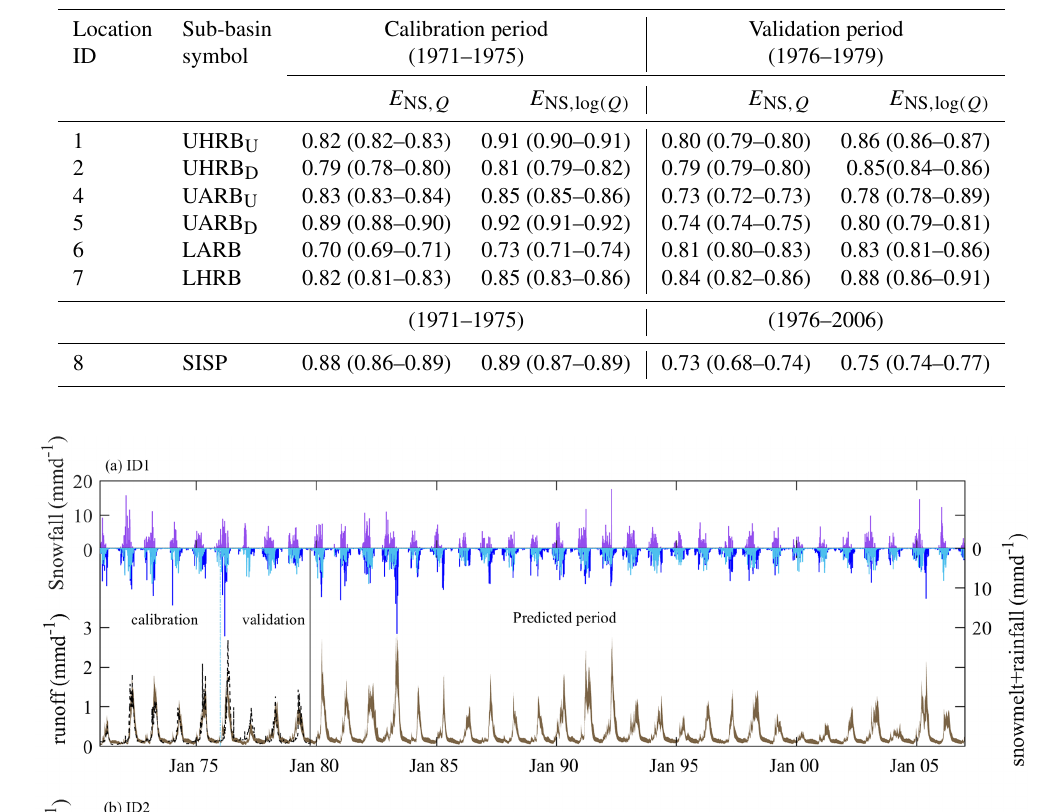
Table 4. Model performance metrics for calibration and validation in all study sub-basins. The values include the best-performing model as well as the range of all solutions retained as feasible (in brackets).